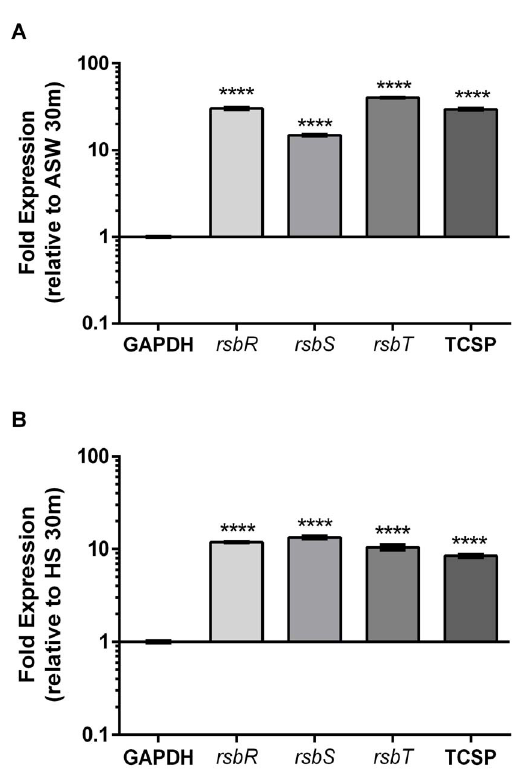
Fig. 4. Temporal gene expression of the stressosome during exposure to A) artificial seawater or B) human serum. Relative qRT-PCR was performed on CMCP6 to examine expression of select stressosome genes ( rsbRST and a downstream two-component sensory protein, here denoted ‘‘TCSP’’) after incubation in each condition for 2 hrs relative to 30 min. GAPDH was used to normalize expression data. Asterisks represent significant differences in expression p , 0.0001 (One-way